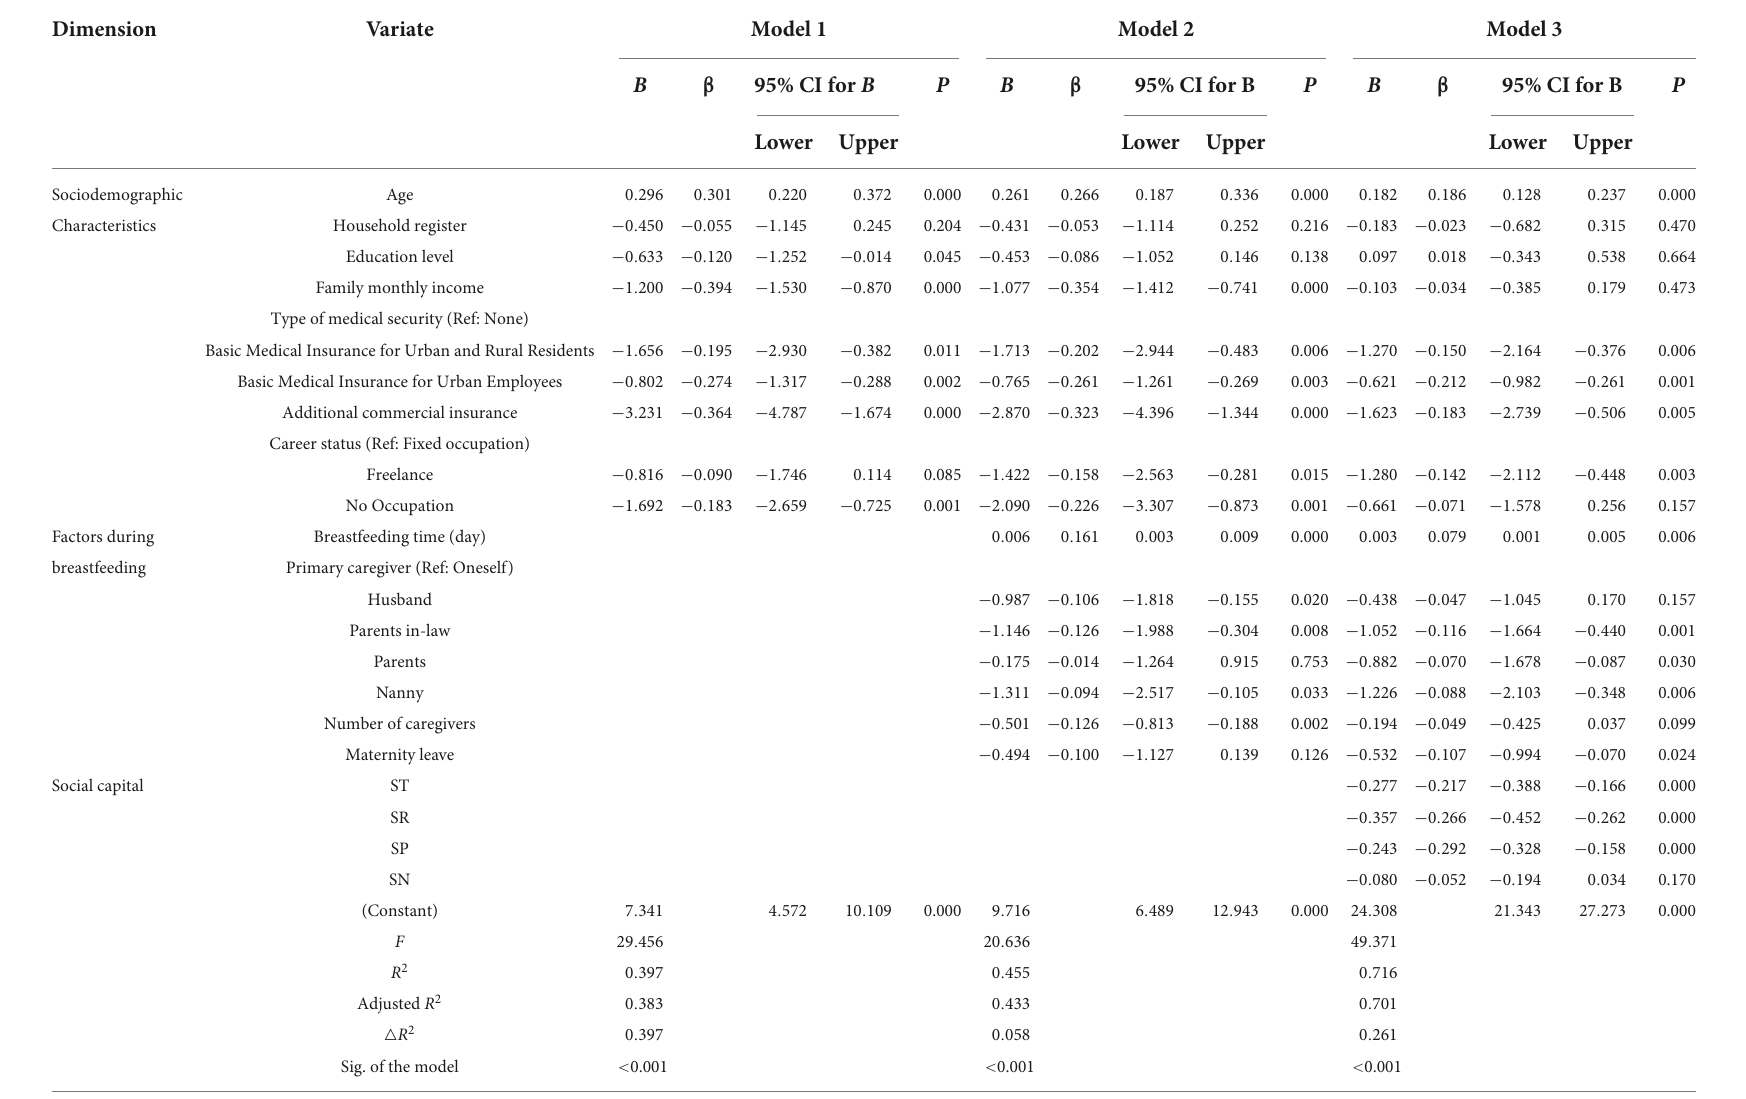
TABLE 4 Hierarchical regression analysis of variables affecting postpartum depression